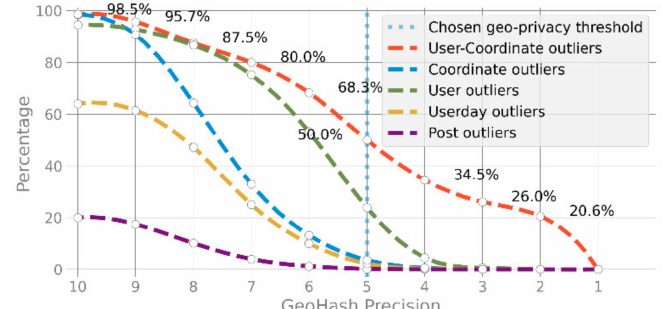
Figure 3. Percentage of global spatial outlier volume (k = 1) in the Yahoo Flickr Creative Commons 100 Million (YFCC100M) dataset, for decreasing precision levels (GeoHash) and di ff erent metrics used in this paper (to reproduce this graphic, see Supplementary Materials,